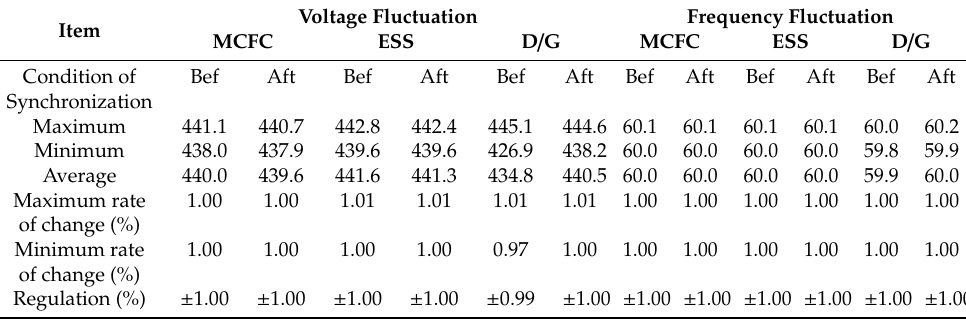
Table 12. Power data analysis before and after diesel generator synchronization.